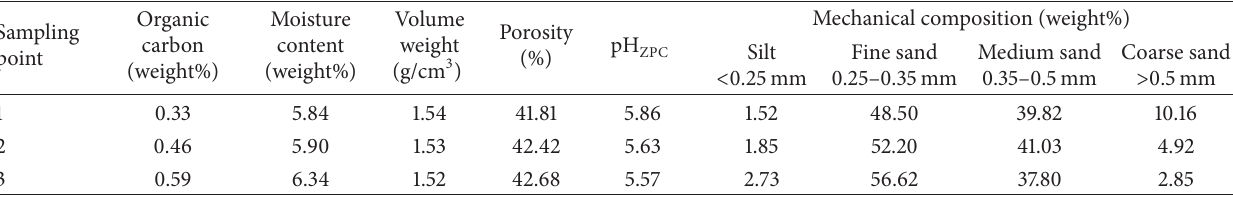
Table 1: Physicochemical property of the sediment samples.